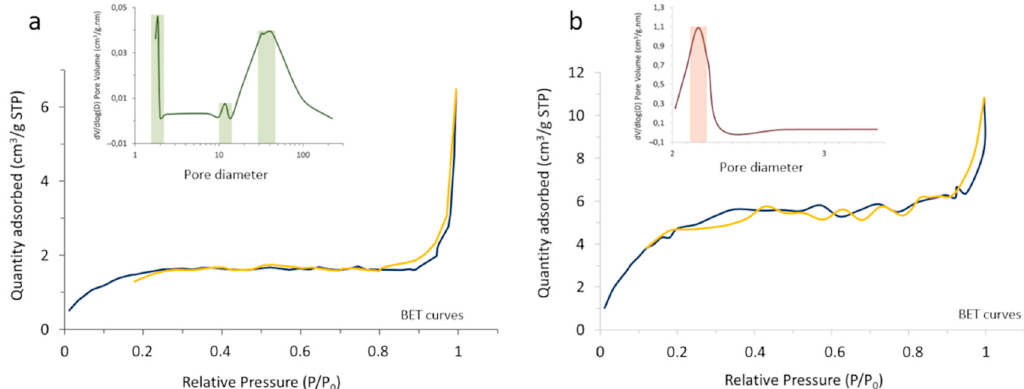
Figure 5. N 2 adsorption (blue)–desorption (yellow) BET isotherms and pore size distribution of ( a ) the as-prepared SrAlO:Eu,Dy@SiO 2 powder and ( b ) the powder calcined at 400 °C/30 min.